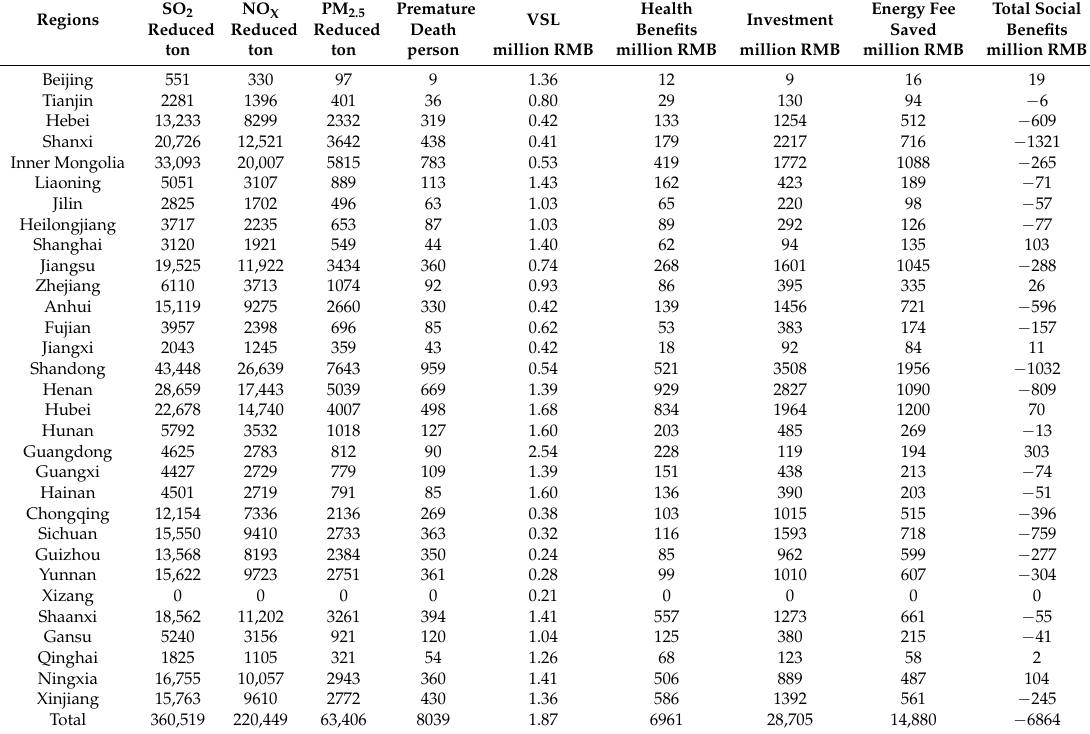
Table 6. Chemical industry provincial